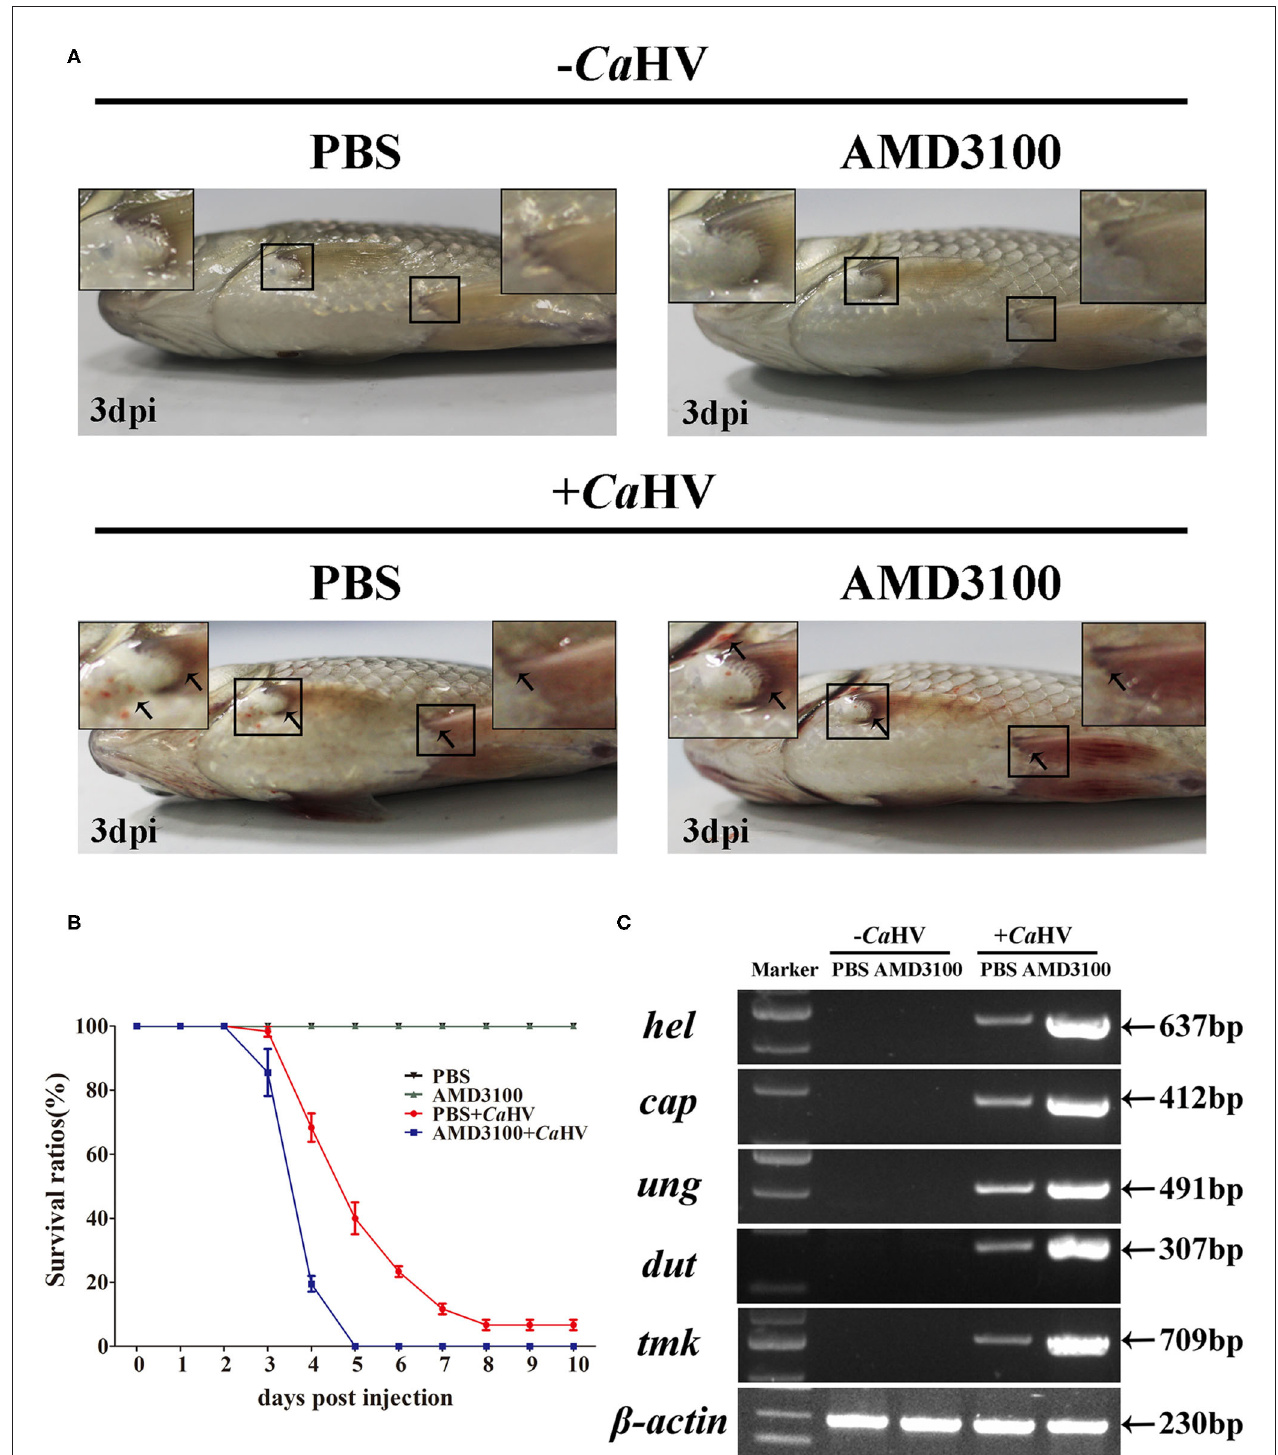
FIGURE 4 | Gibel carp treated with AMD3100 were more sensitive to Ca HV infection. (A) Representative images of gibel carp, both un-infected group (– Ca HV) and infected group ( + Ca HV) were photographed at third day after intraperitoneal injection PBS (– Ca HV) or Ca HV ( + Ca HV), along with the treatment of vehicle (PBS; the control) or AMD3100 (100 µ g in 200 µ l PBS) every 24h. Un-infected gibel individuals appeared normal while infected individuals exhibited hemorrhage at the base of